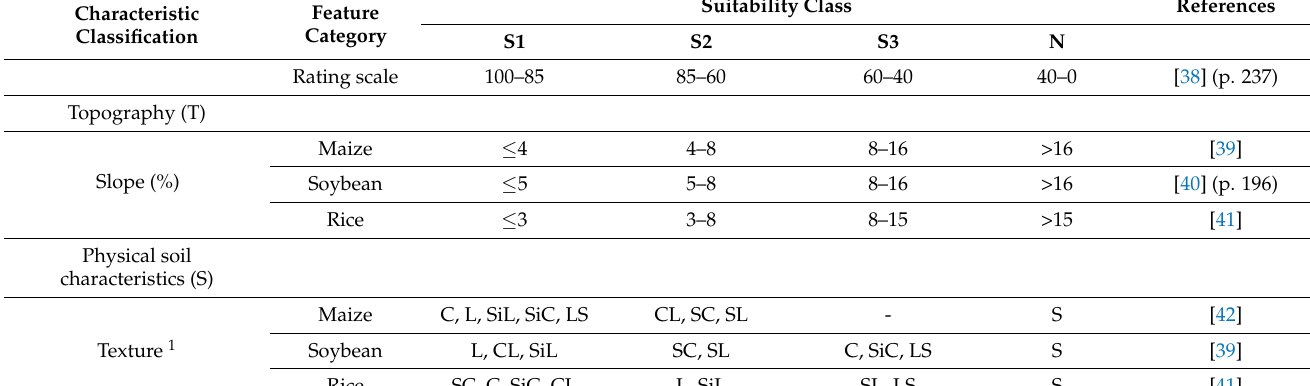
Table 1. Factor ratings of land suitability for maize, rice, and soybean